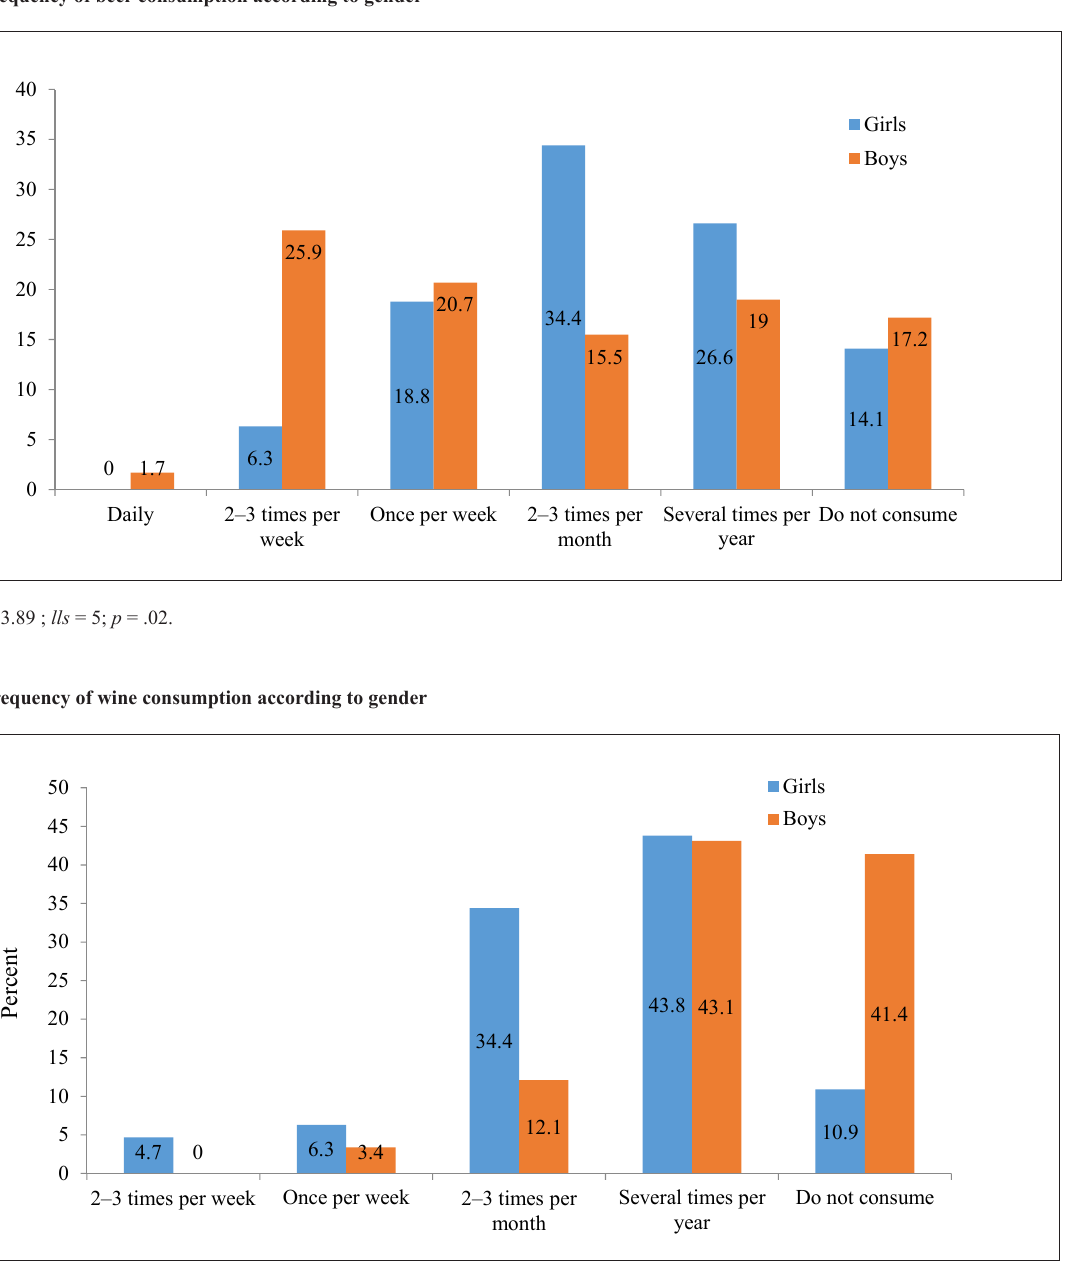
Figure 1. Frequency of beer consumption according to gender